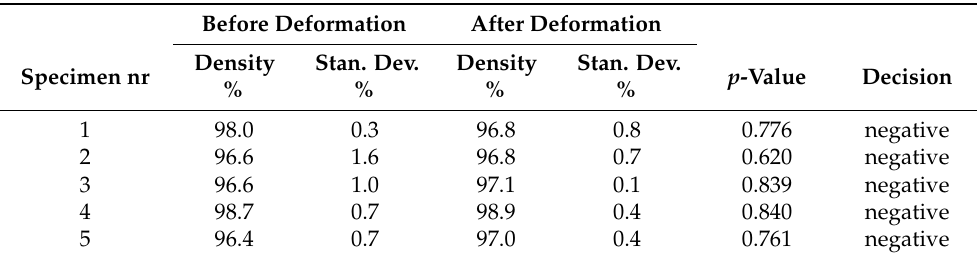
Figure 5. Density of specimens before and after the compression test. Table 3. Statistical comparison results ( t -test) of specimen density before and after the compression